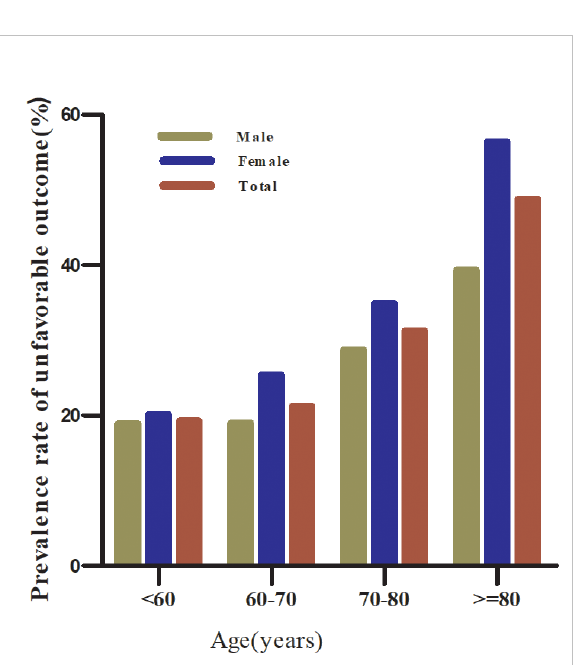
FIGURE 4 The prevalence of unfavorable outcomes among participants according to age strati fi